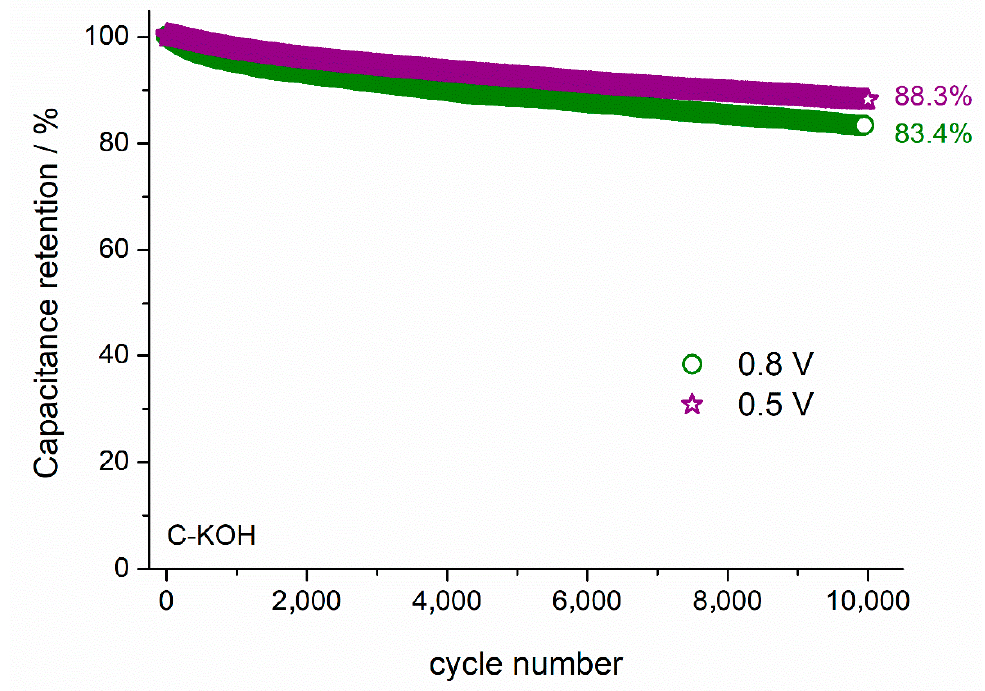
Figure 8. The capacitance retention dependence on the cell voltage during 10,000 GCD cycles at 1 A g − 1 recorded for the symmetric capacitor with C–KOH electrodes.